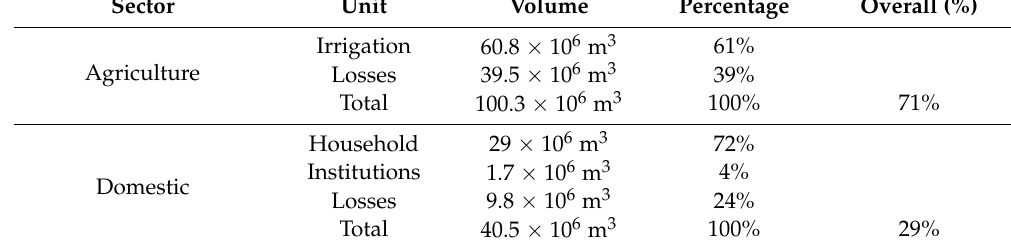
Table 4. Annual water demand by sector and principal use in 2010 [26,27].